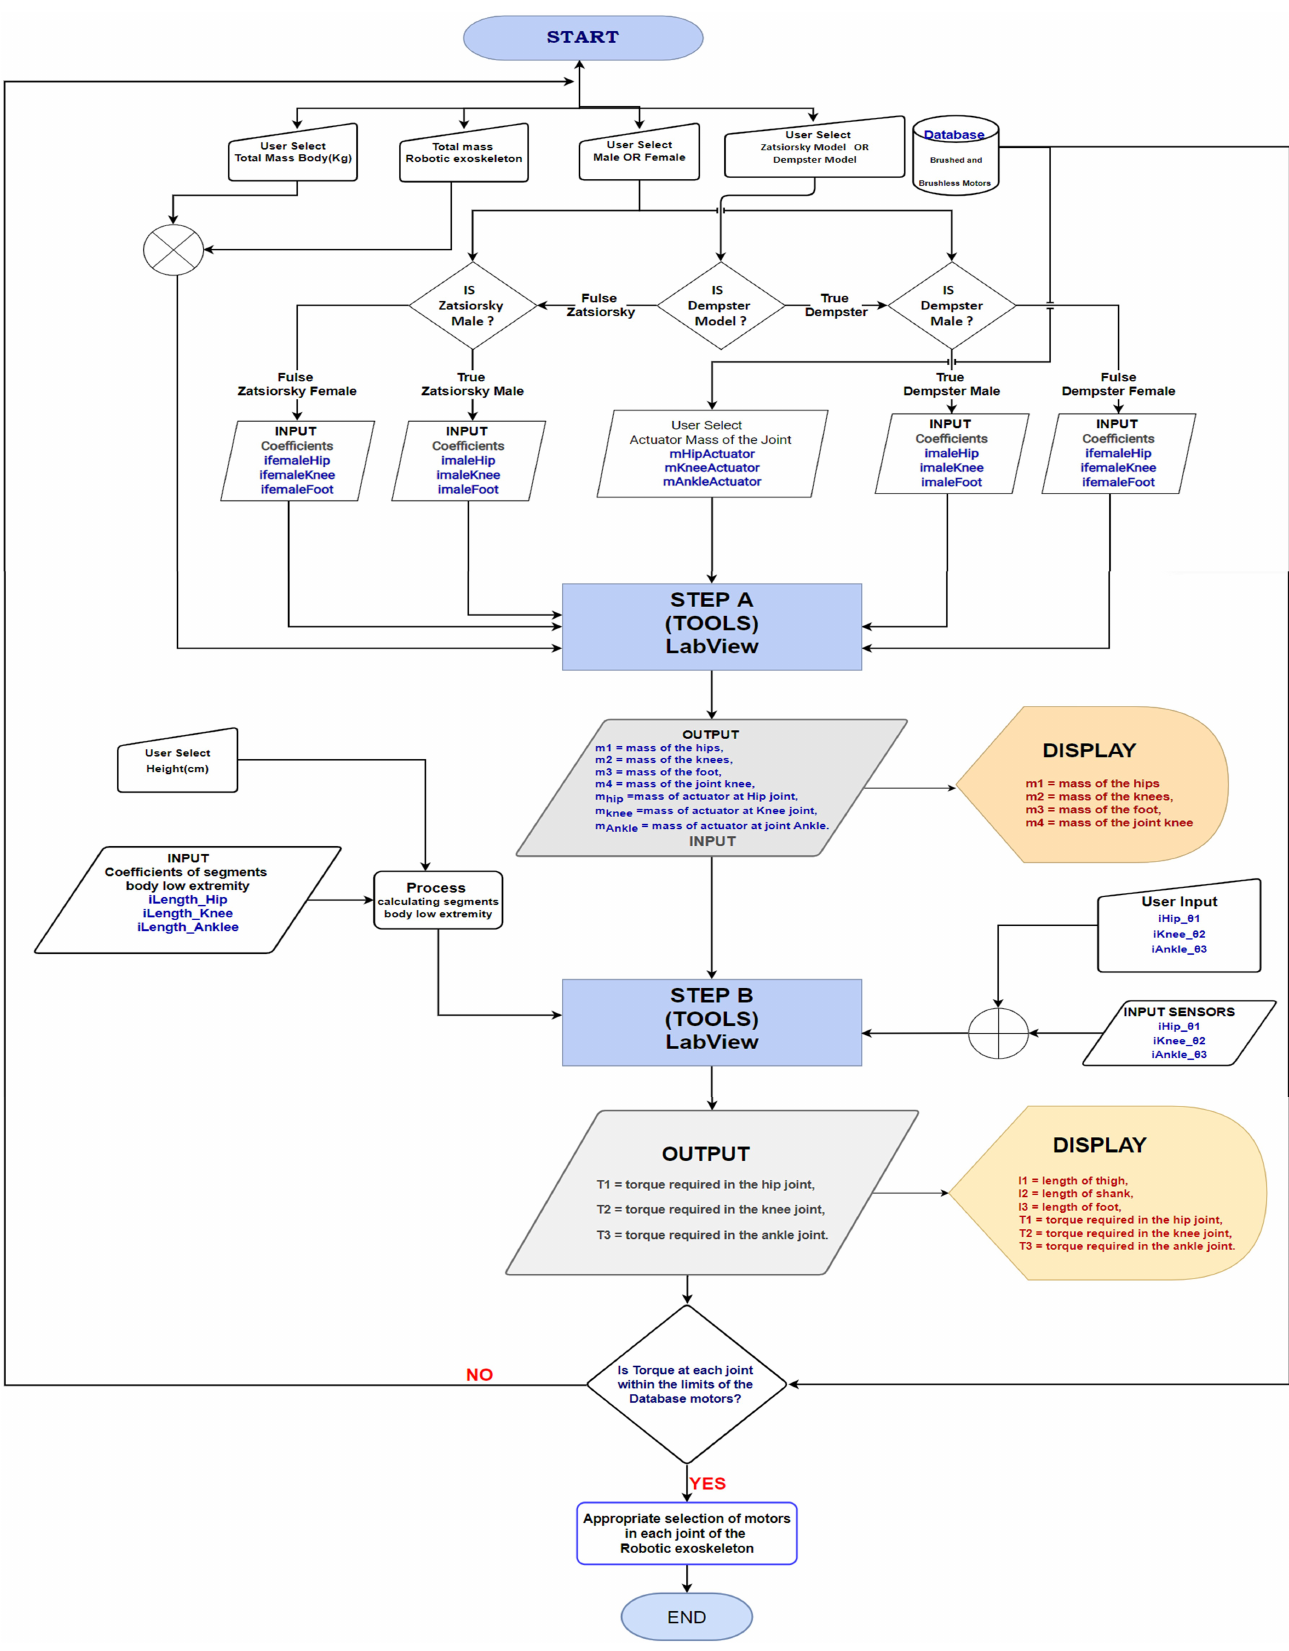
Figure 5. Flow chart